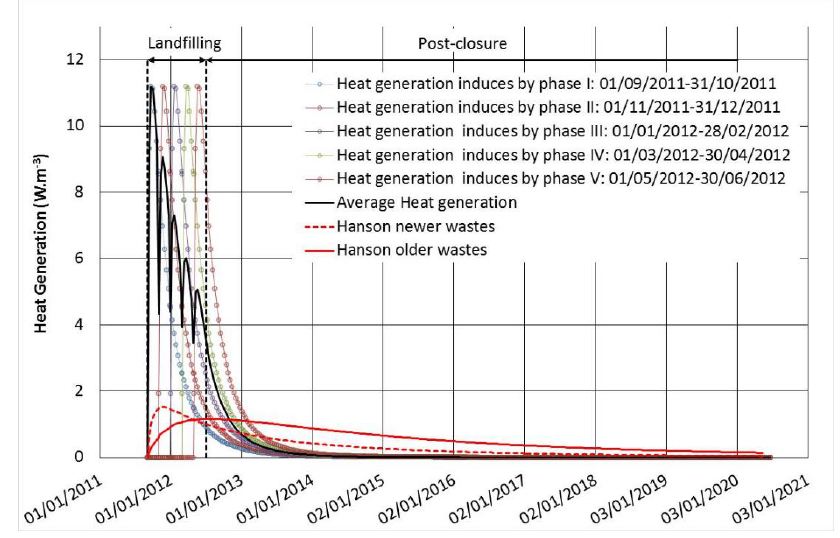
Figure 9. Heat generation evolution during the landfilling and post closure periods for CELL4 and for Hanson’s data [32]. Hanson’s data